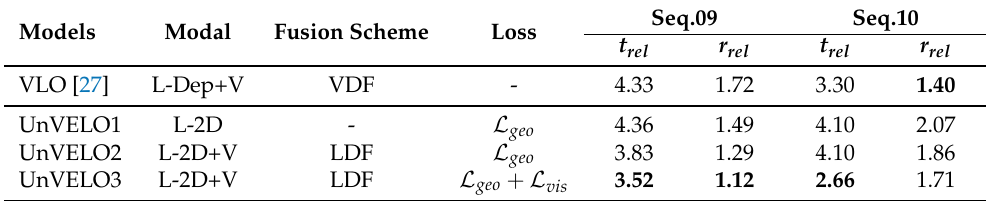
Table 1. The performance of our pose-estimation network and its variants. The Modal column denotes the modalities of the network inputs, where “L” stands for LiDAR and “V” stands for visual. The best results are bold.